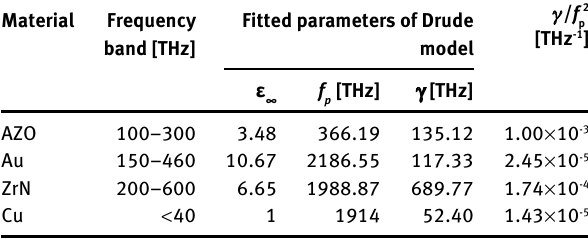
Table 1 Fitted parameters of Drude model and value of γ 2 acterizing the ohmic loss) for different materials, i.e., AZO, Au, ZrN and